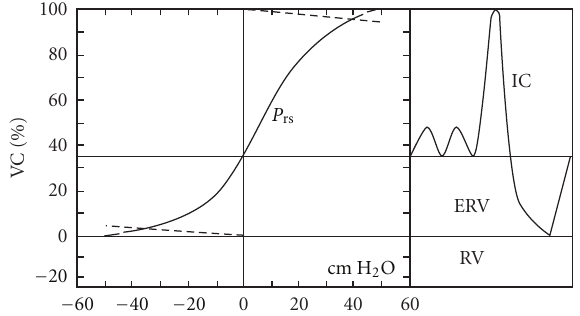
Figure 2: Quasistatic P-V curve of the respiratory system, with a spirogram showing subdivisions of lung volume. ERV: expiratory reserve volume, IC: inspiratory capacity, VC: vital capacity. Adapted from Agostini and Hyatt